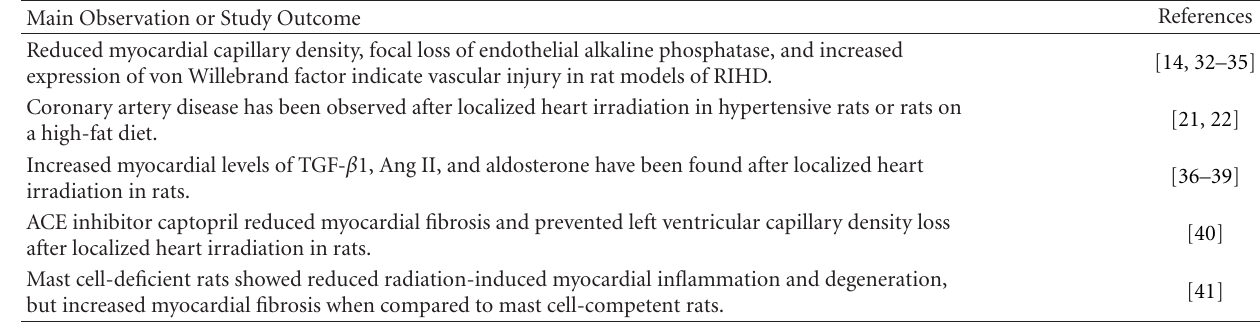
Table 1: Summary of pre-clinical studies into basic mechanisms of